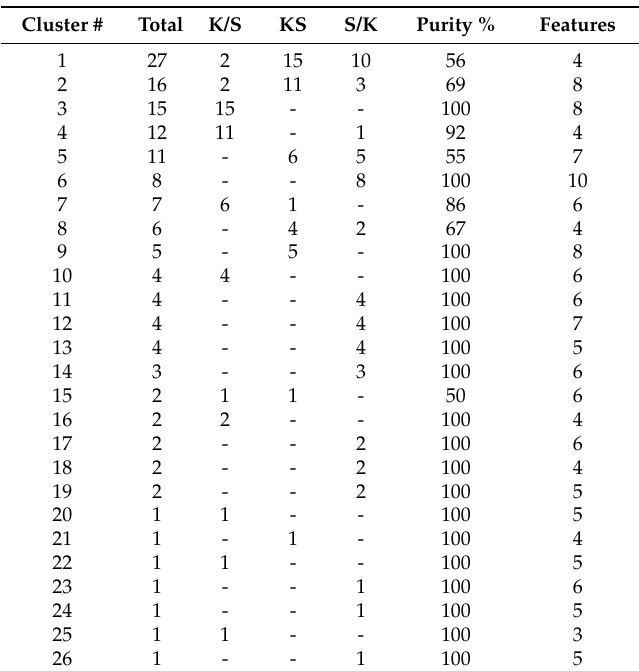
Table 3. Analysis of BAPS fingerprint